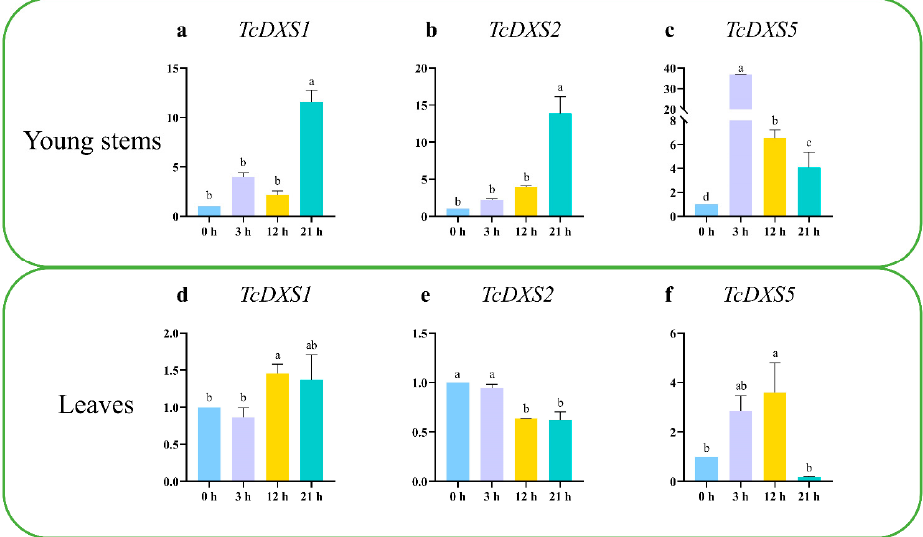
10 of 17 Figure 7. Expression patterns of TcDXSs genes during 0, 3, 12, and 21 h under H. robusta stress. The data represent the mean of three independent biological replicates relative to 0 h, different letters above the bars represent statistically significant differences ( p < 0.05) detected by a one-way ANOVA test. ( a ) TcDXS1 gene during 0, 3, 12, and 21 h under H. robusta stress in young stems. ( b ) TcDXS2 gene during 0, 3, 12, and 21 h under H. robusta stress in young stems. ( c ) TcDXS5 gene during 0, 3, 12, and 21 h under H. robusta stress in young stems. ( d ) TcDXS1 gene during 0, 3, 12, and 21 h under H. robusta stress in leaves. ( e ) TcDXS2 gene during 0, 3, 12, and 21 h under H. robusta stress in leaves. ( f ) TcDXS5 gene during 0, 3, 12, and 21 h under H. robusta stress in leaves.